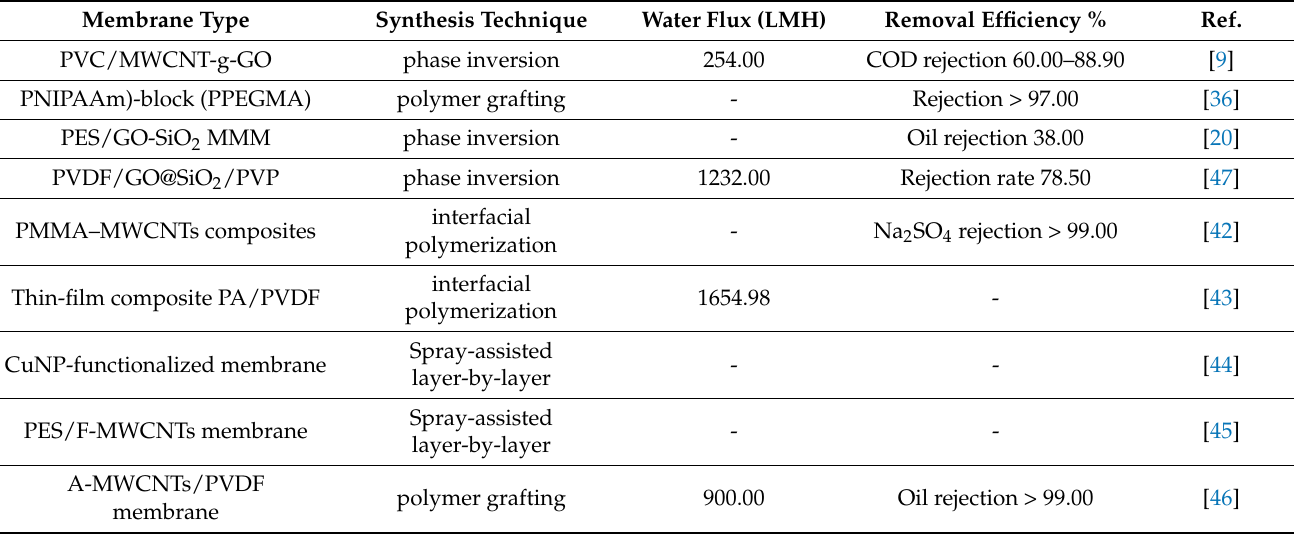
Table 4. Examples of research on the most common synthesis technique of